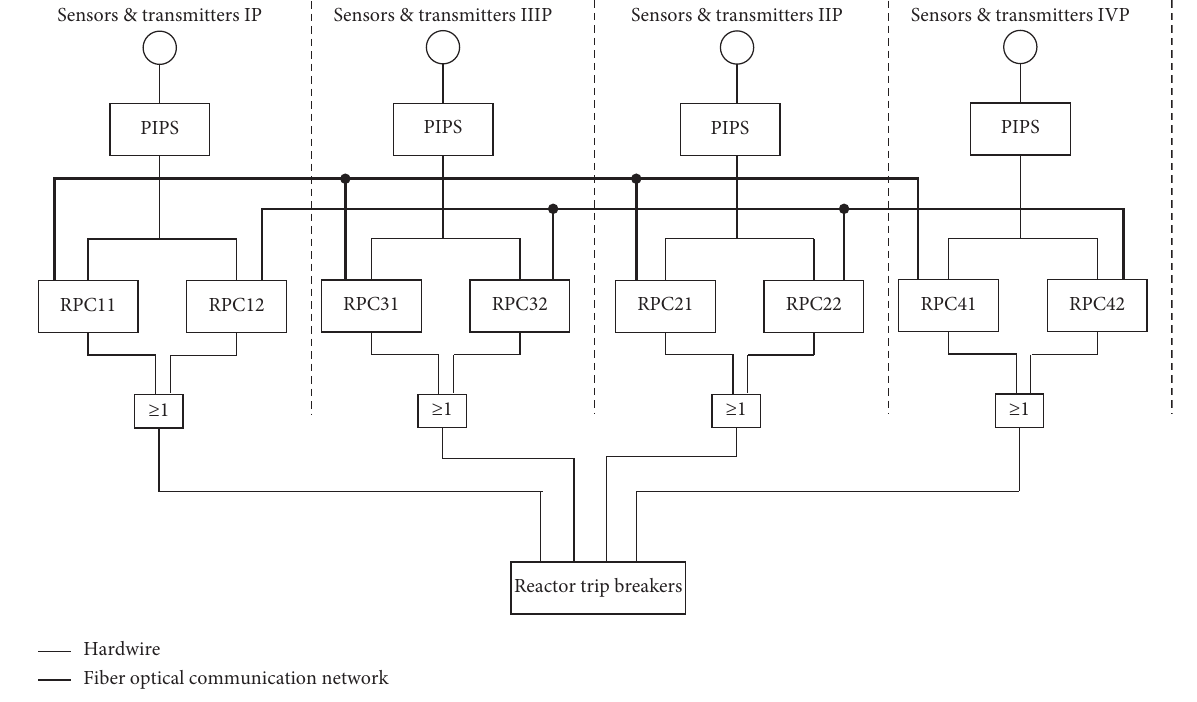
Figure 1: The schematic diagram of the four-channel RPS.